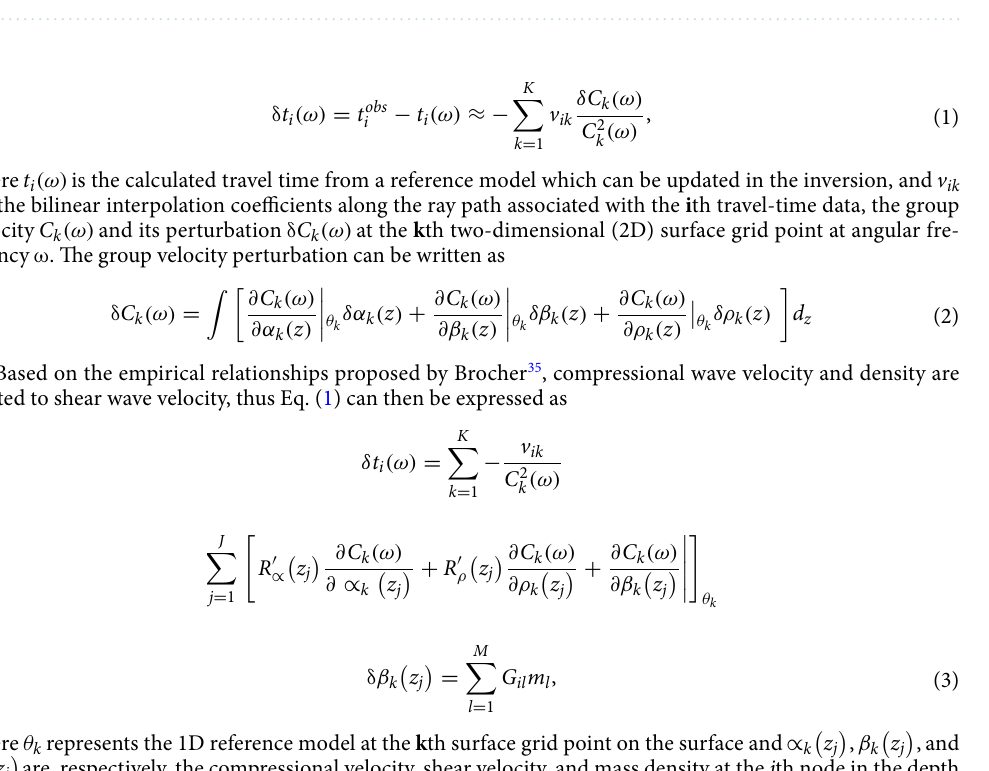
Figure 4. Group velocity dispersion curves in the 0.5–5 s period